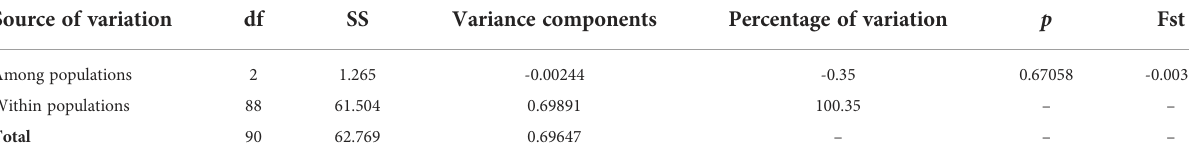
TABLE 3 Analysis of molecular variance of the cytochrome c oxidase subunit I region of D. pleii mtDNA, from the Yucatan Shelf, SGoM. Source of variation